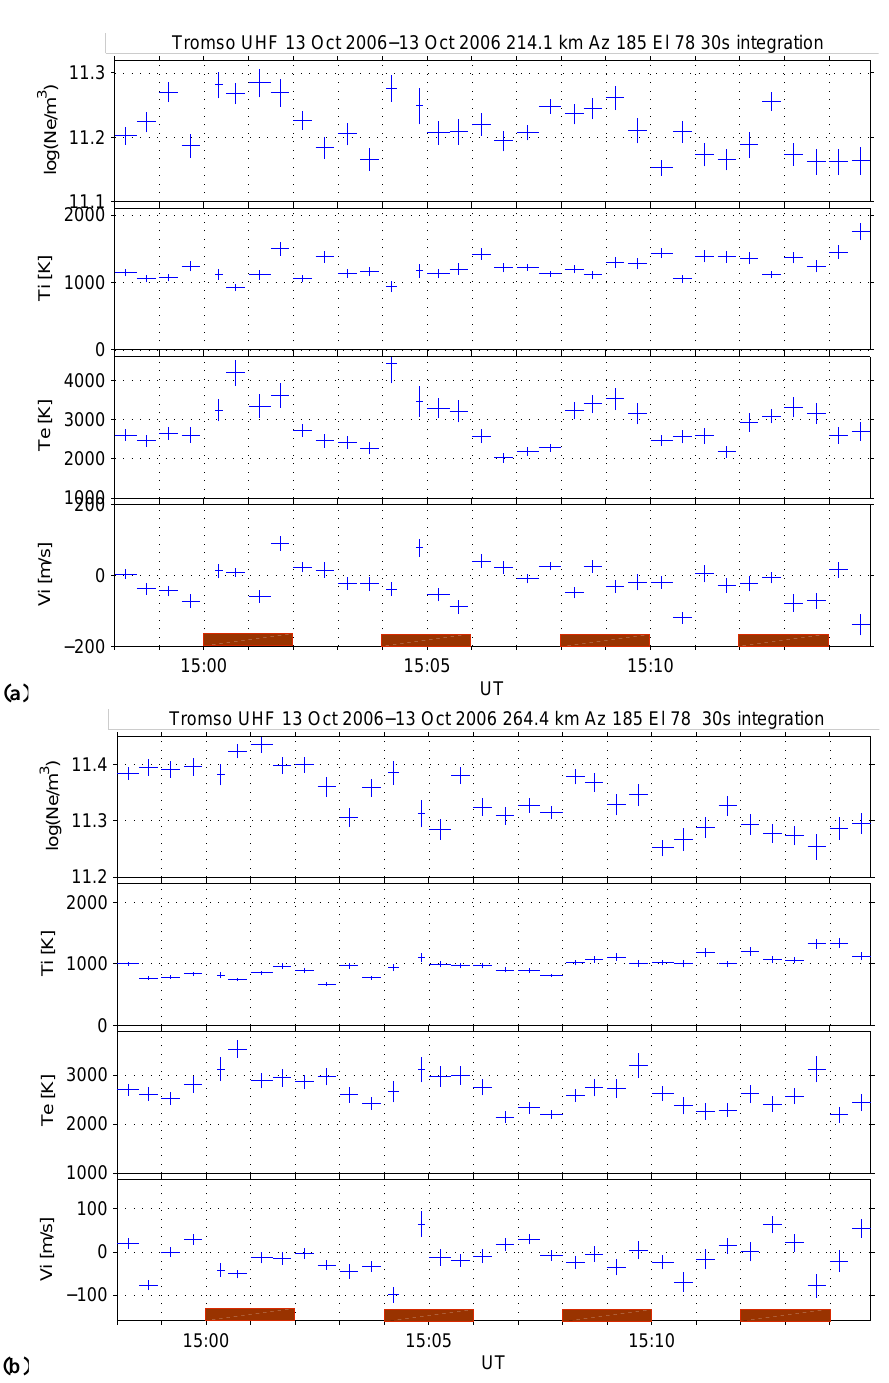
Fig. 7b Fig. 7. Temporal variations of the electron density, N e , ion and electron temperatures, T i and T e , and the ion velocity, V i , from the EISCAT UHF radar observations on 13 October 2006 from 14:58 to 15:15UT at different altitudes: (a) 214km; (b) 264km.